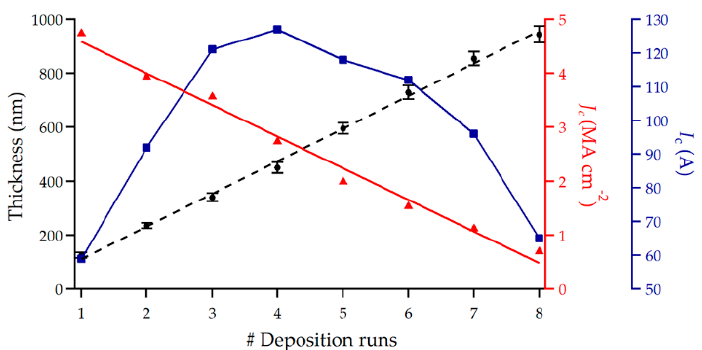
Figure 4. Experimental values of thickness and the inductively measured self-field critical current densities at 77 K and a normalized critical current after different deposition runs using pristine YBCO ink.